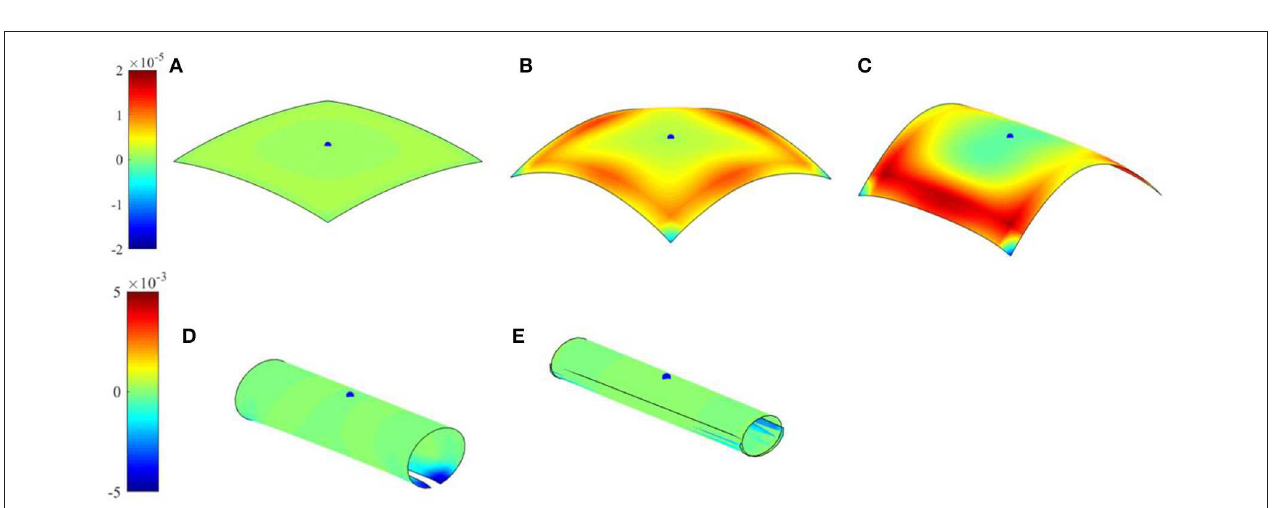
FIGURE 3 | Gaussian curvature of folded square plate. (A) Electric field 9 MV/m; (B) electric field 15 MV/m; (C) electric field 18 MV/m; (D) electric field 68 MV/m; and (E) electric field 86 MV/m.